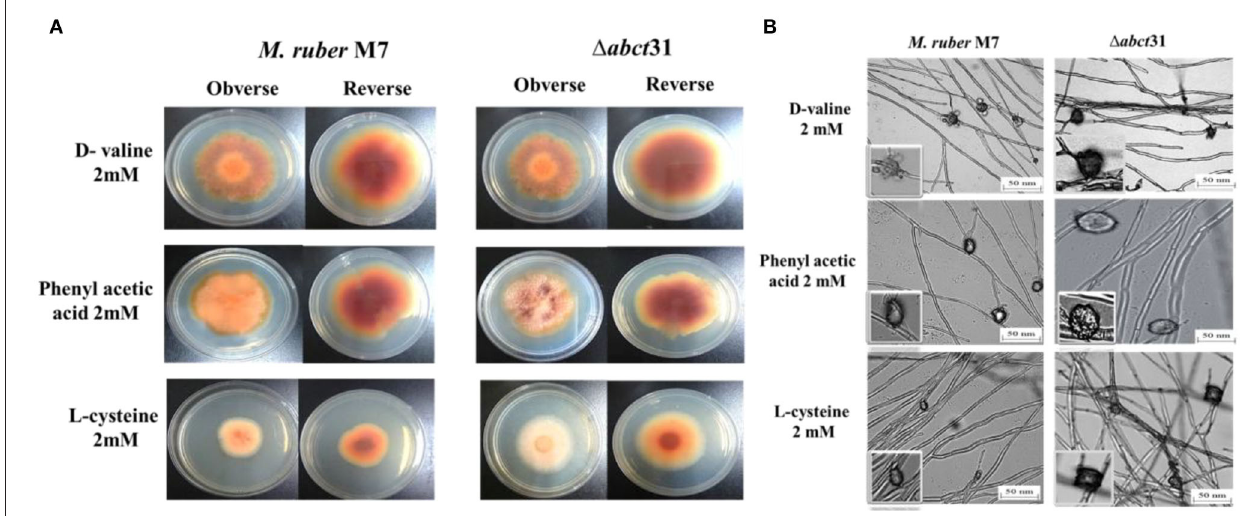
FIGURE 8 | Morphological comparison of M. ruber M7and 1 abct 31 to evaluate the sensitivity toward pathway amino acid supplementation. (A) Colony morphology of M. ruber M7 and 1 abct 31 inoculated on PDA plates supplemented with D-valine, phenylacetic acid, and L-cysteine at 2mM concentrations for each cultured at 28 ◦ C for 15 days. (B) Cleistothecia and conidia development in M. ruber M7 and 1 abct 31 cultured on PDA plates which supplemented with D-valine, phenylacetic acid, and L-cysteine at 2mM concentrations for each and cultured at 28 ◦ C for 10